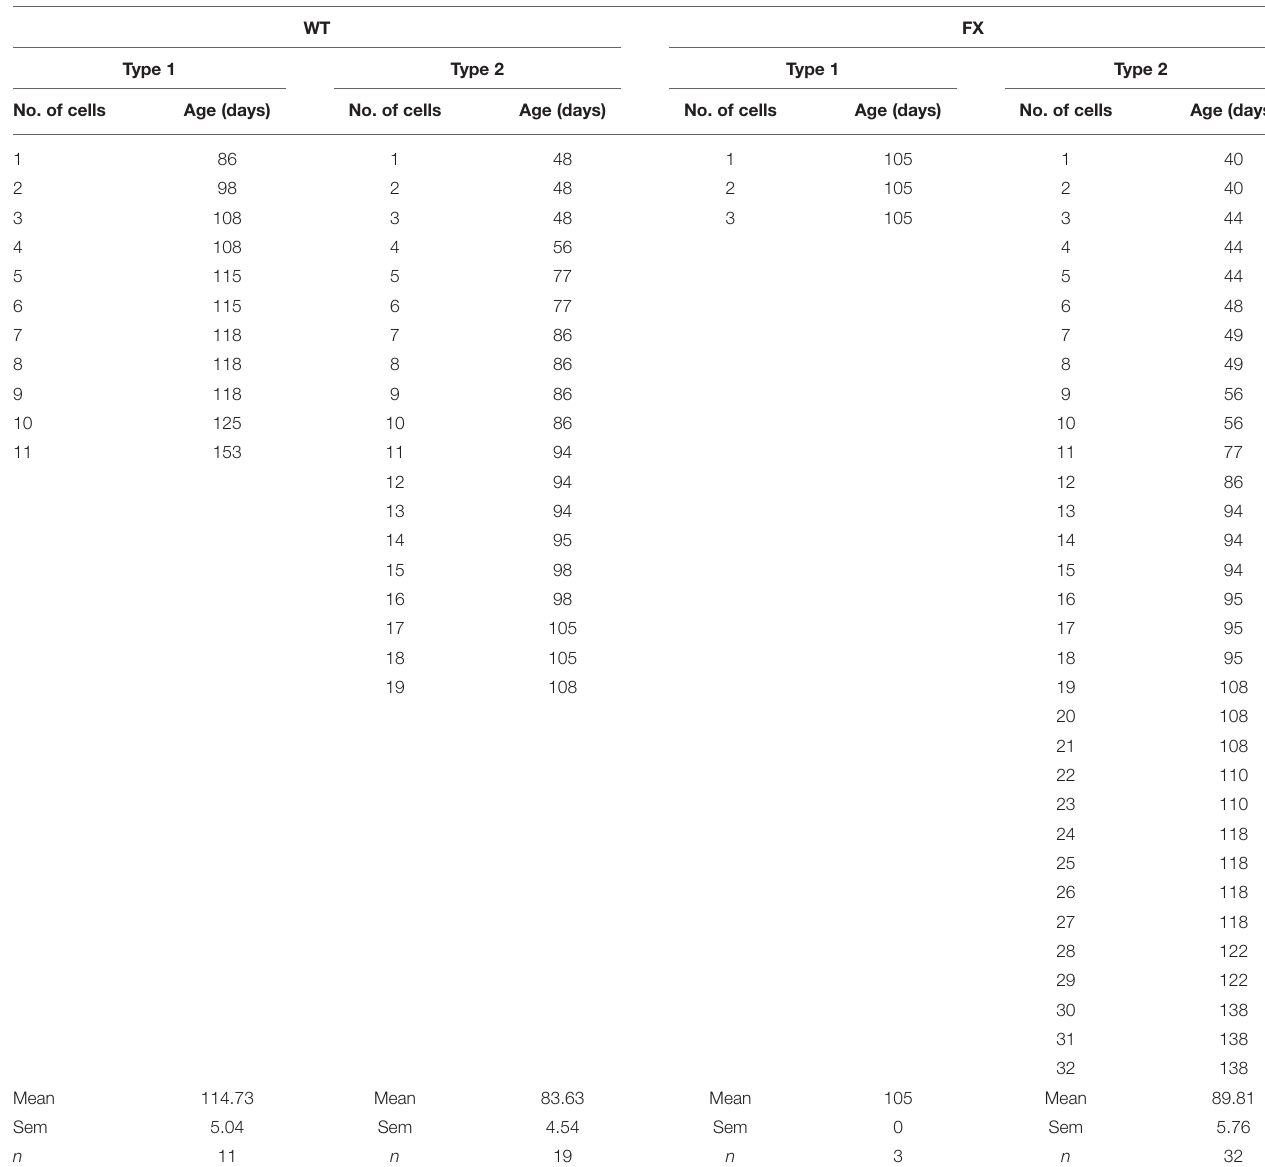
TABLE 1 | Full data for age distribution.